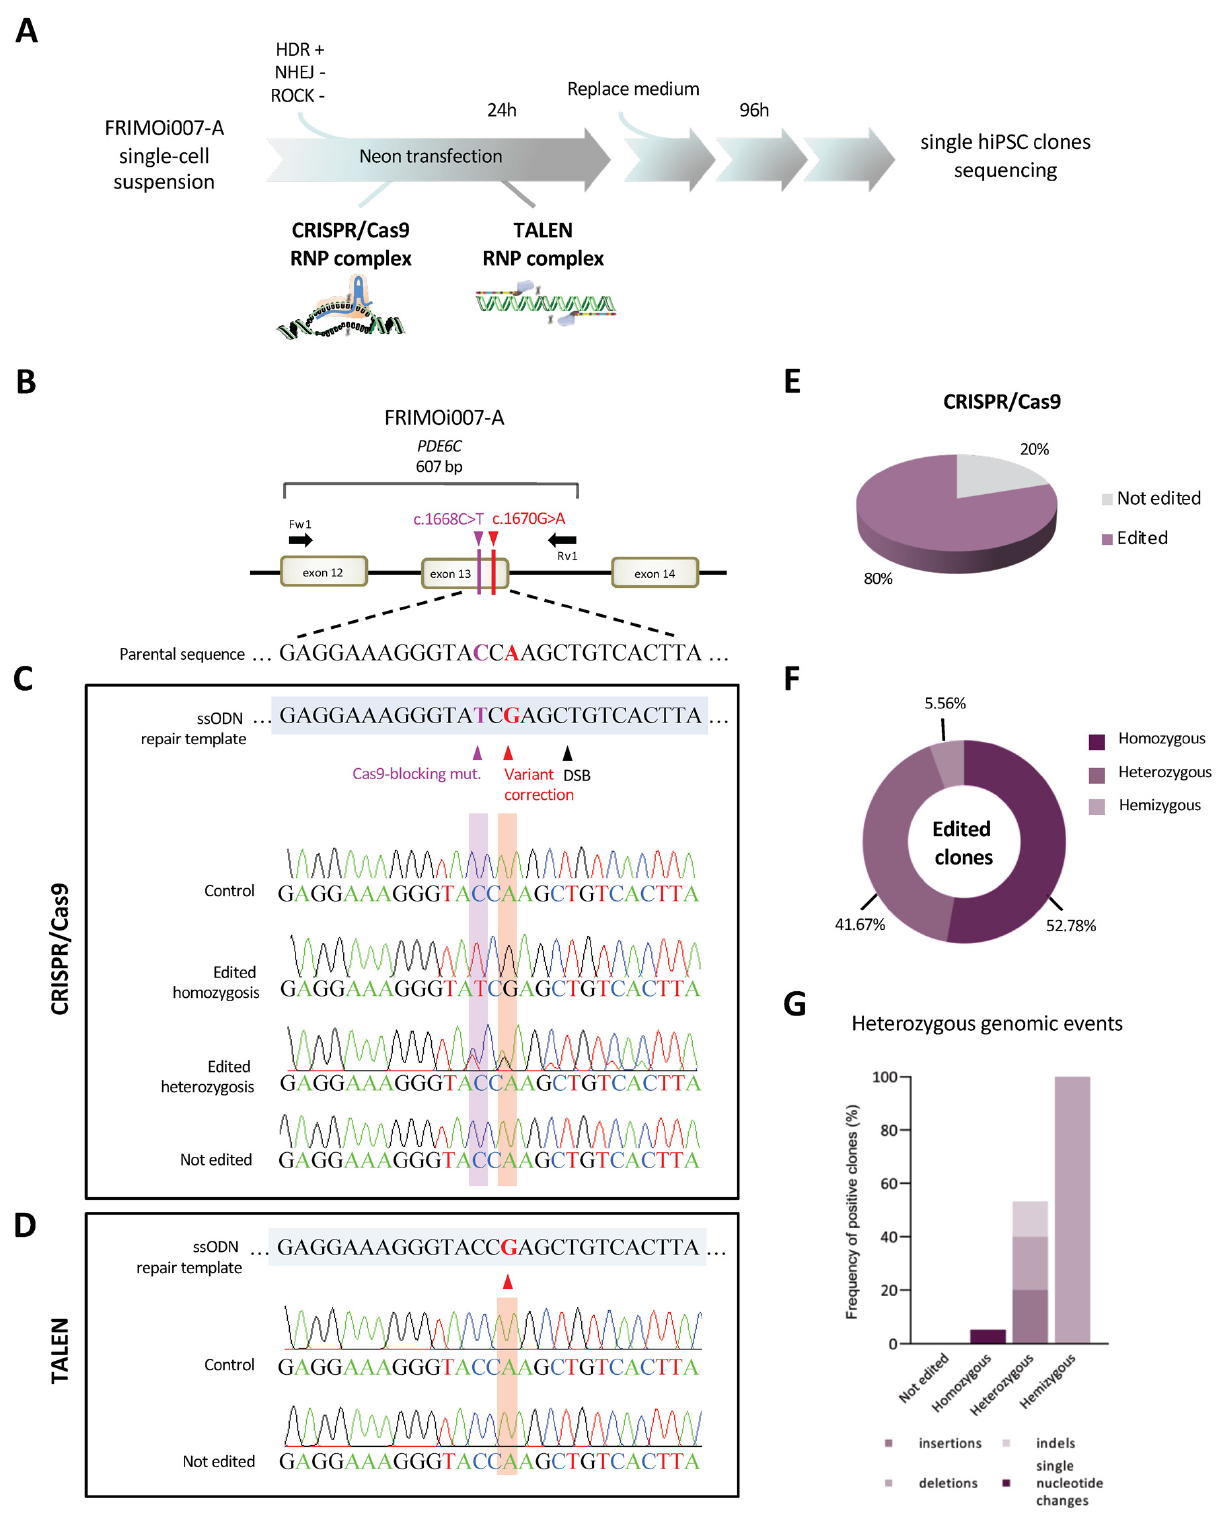
Figure 3. Highly efficient genome editing of a PDE6C pathogenic variant by CRISPR/Cas9 in hiPSCs and identification of on-target genomic defects. ( A ) Schematic representation of the assay conditions followed for CRISPR/Cas9 and TALEN-mediated genome editing in FRIMOi007-A. After 96h of cell culture, single colonies were picked and grown for analysis of the clones. The figure was